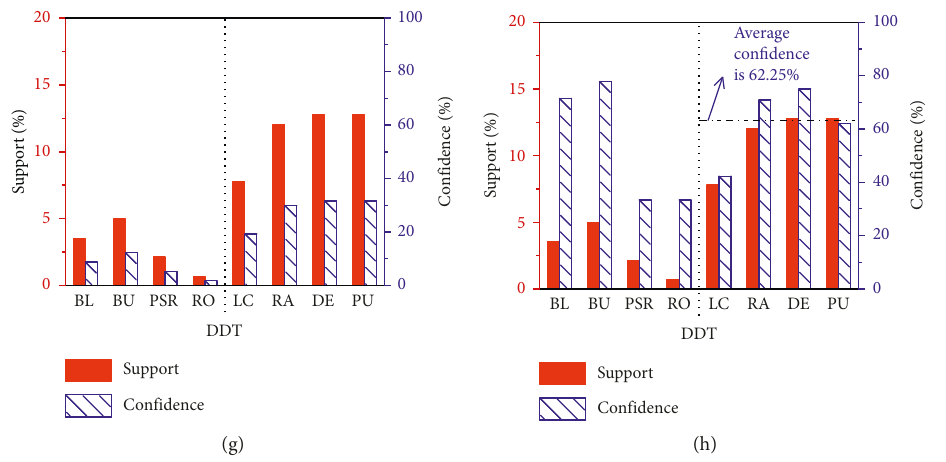
Figure 7: Association rules between IDDTs and DDTs. (a) TC ⟶ DDTs. (b) DDTs ⟶ TC. (c) RU ⟶ DDTs. (d) DDTs ⟶